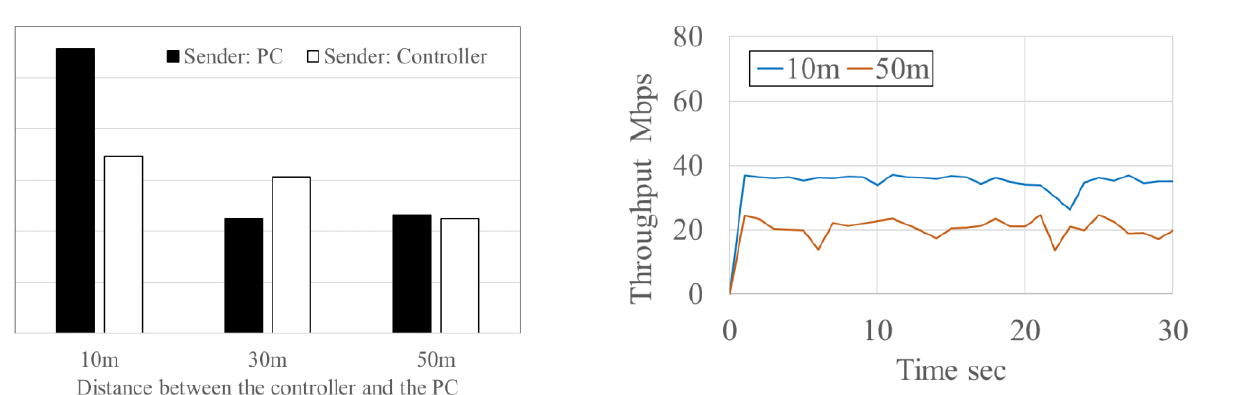
Figure 14. Temporal evolution of UDP throughput in each communication distance (Sender is controller): The blue line is the 10 m results, and the orange line is the 50 m results.